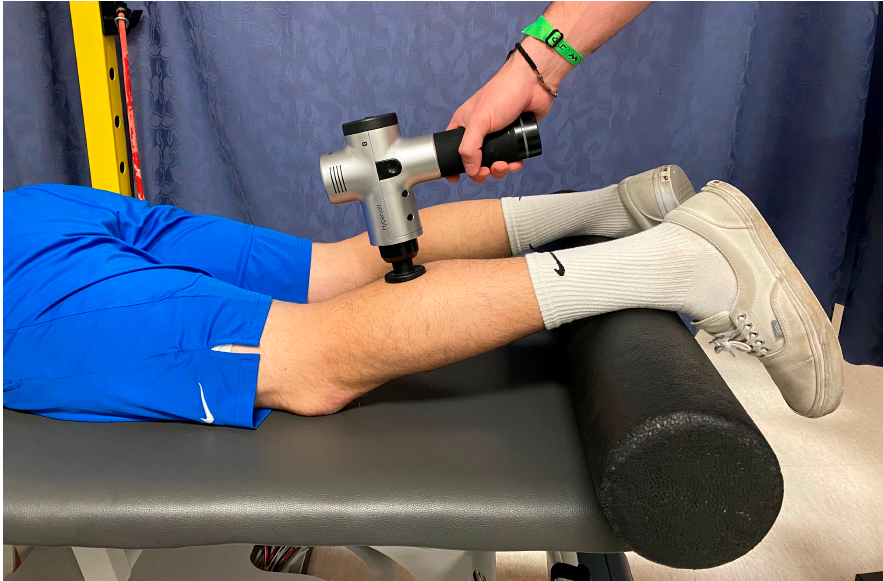
Figure 1. A representative subject is shown to demonstrate the position of each subject when ther- apy was